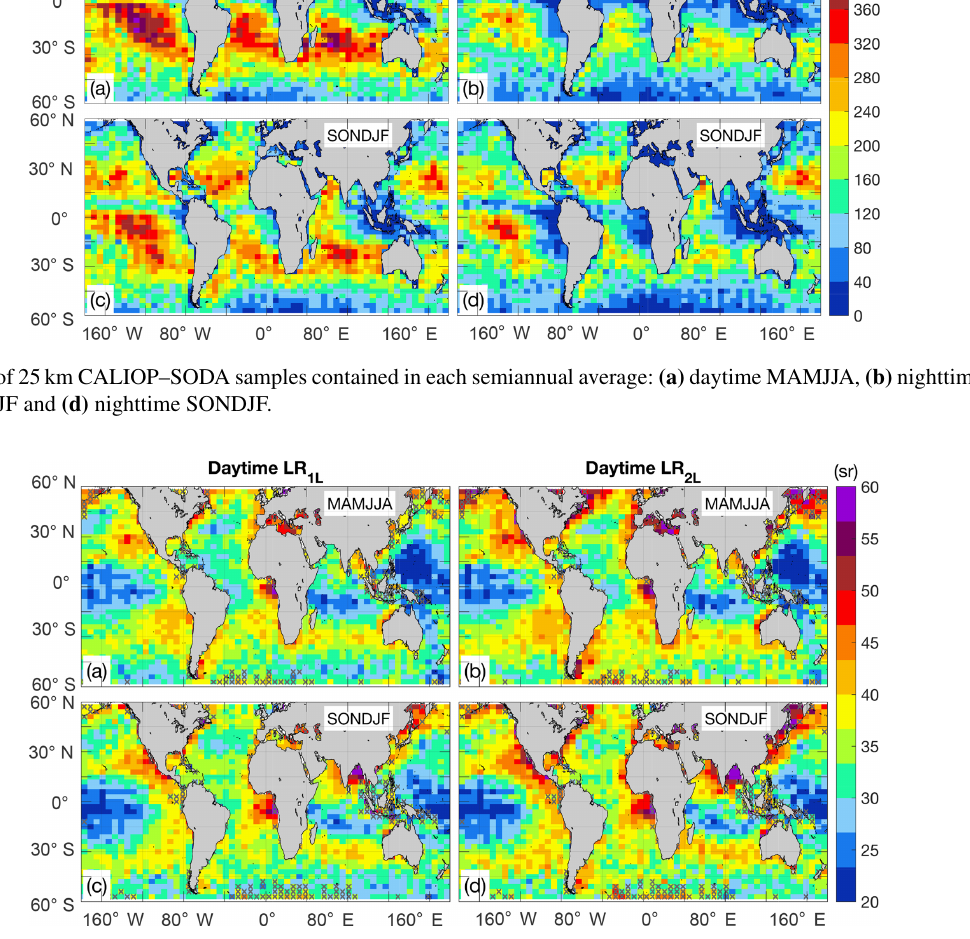
Figure 9. Semiannual daytime 532nm lidar ratios. (a) LR 1L for spring–summer, (b) LR 2L for spring–summer, (c) LR 1L for autumn–winter and (d) LR 2L for autumn–winter. Gray crosses indicate regions where less than 15% of the maximum observable number of samples contribute to the